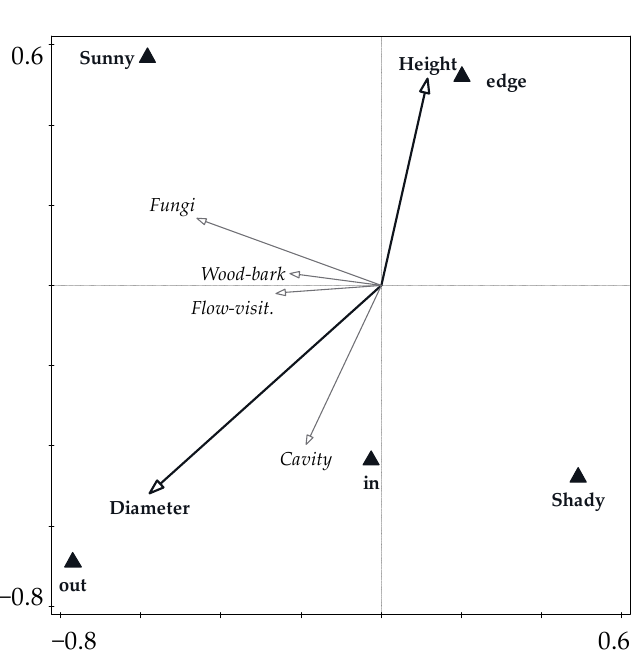
Figure 11. Microhabitat guilds and their preferences for variables in heritage trees by RDA (pF = 1.2; p = 0.282). Explained by axes; axis 1—10.34%; axis 2—6.25%. Solid symbols are categorical variables and arrows of DBH and height are continuous variables.